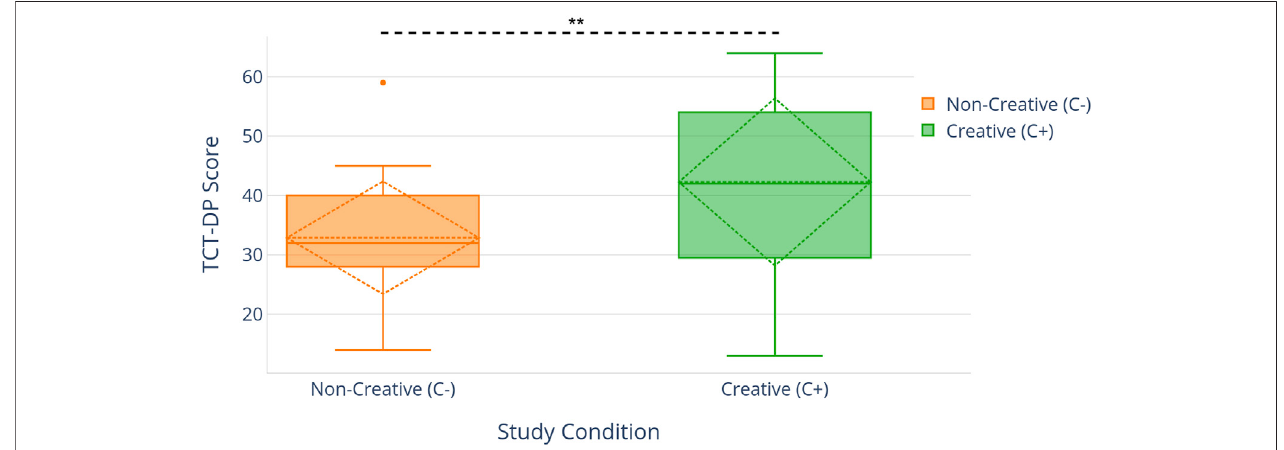
FIGURE 7 | Participants who interacted with the high creative robot scored signi fi cantly higher on the TCT-DP test compared to the low creative robot condition (H2).